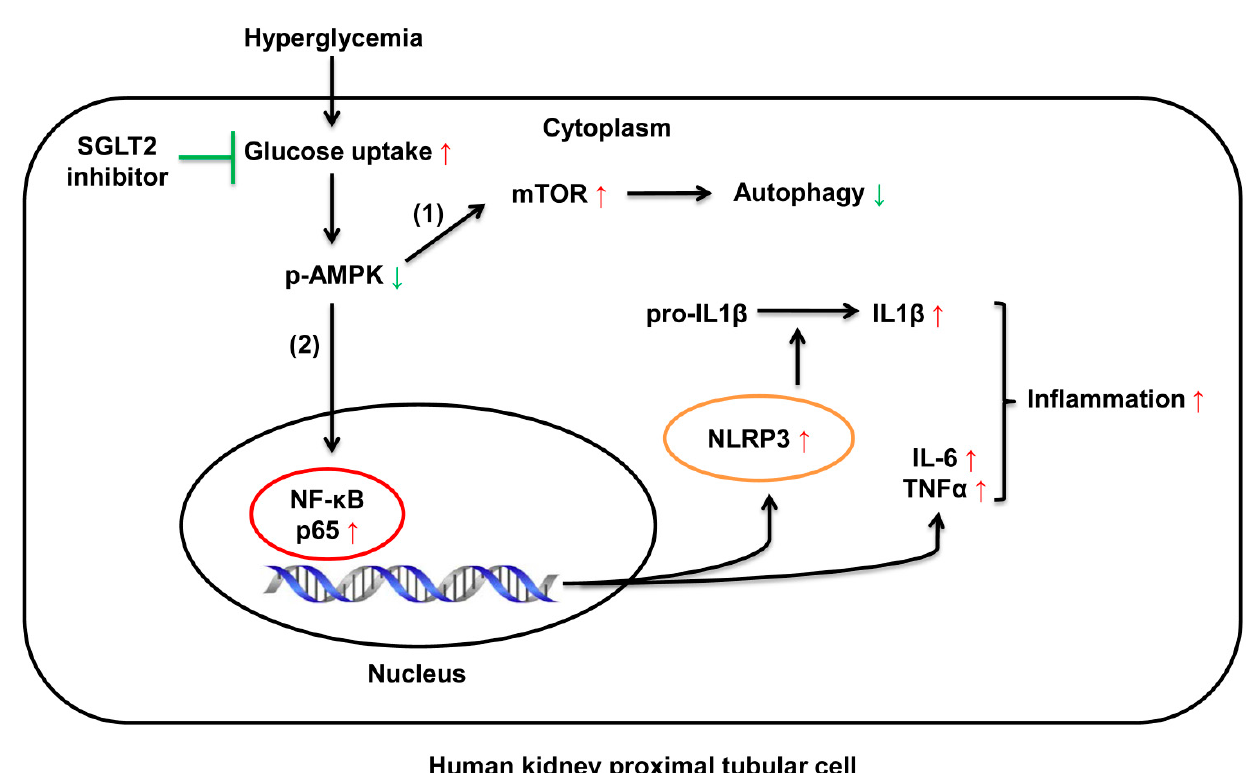
Figure 8. The mechanism of SGLT2 inhibition in diabetic renal proximal tubular cells. High glucose-induced decrease in AMPK activity is involved in (1) mTOR activation and autophagic flux reduction and (2) inflammatory alterations (inflammasome activation and increased TNF α and IL-6 expression) due to NF- κ B (p65) pathway activation. Dapagliflozin attenuates the alterations caused by high